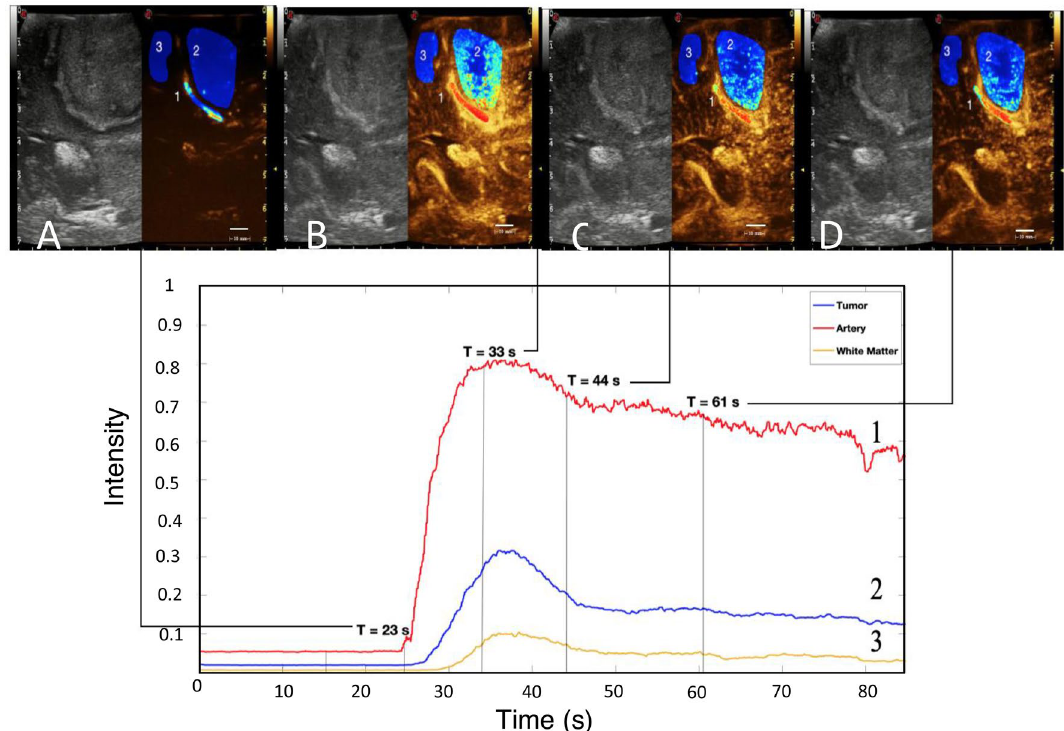
Figure 3. Time intensity curve correlation with phases of the microbubble life cycle, showing different amount of microbubble in the same area. ( Artery (red-1), Tumor (blue-2), White Matter (yellow-3) ) In the upper panel 4 screenshot with low-MI B-mode and harmonic imaging in a case of parietal glioma: pre-injection microbubble concentration is at a baseline at 18 s and at 23 s the concentration starts to rise in the artery post-injection ( A ). The second time-point represents the beginning of the wash-in phase post-injection. The intensity is greatest between 33 (peak— B ) and 40 s (early wash out— C ) and has started to wash-out by 44 s. The late wash-out phase at 61 s ( D ) shows a still dense distribution of microbubbles in the artery, while the white matter has returned to approximately